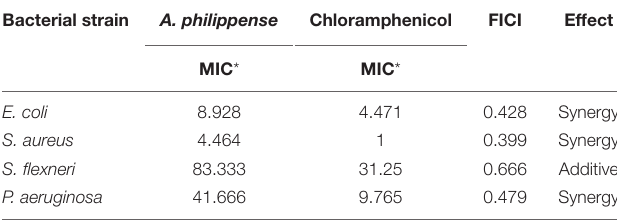
TABLE 3 | FICI determination of A. philippense crude extract. Bacterial